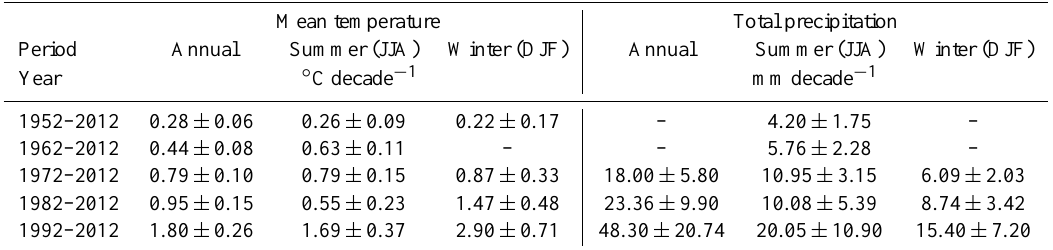
Table 1. Temperature ± SD and total precipitation (rain + snow, in mmdecade − 1 of water; ± SD) trends at Thule airport (THU), Greenland from 1952–2012. Only statistically significant trends are reported. Errors correspond to + / − 1- σ , or a 68% confidence